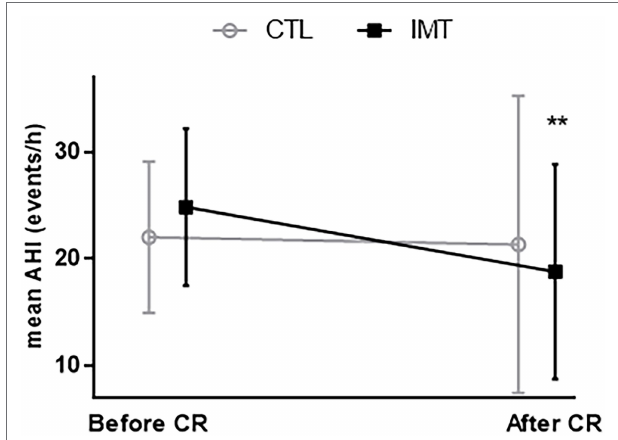
FIGURE 2 | Evolution of apnea-hypopnea index (AHI) before and after cardiac rehabilitation (CR). ** p = 0.003; significant decrease of AHI after cardiac rehabilitation only for IMT group (black